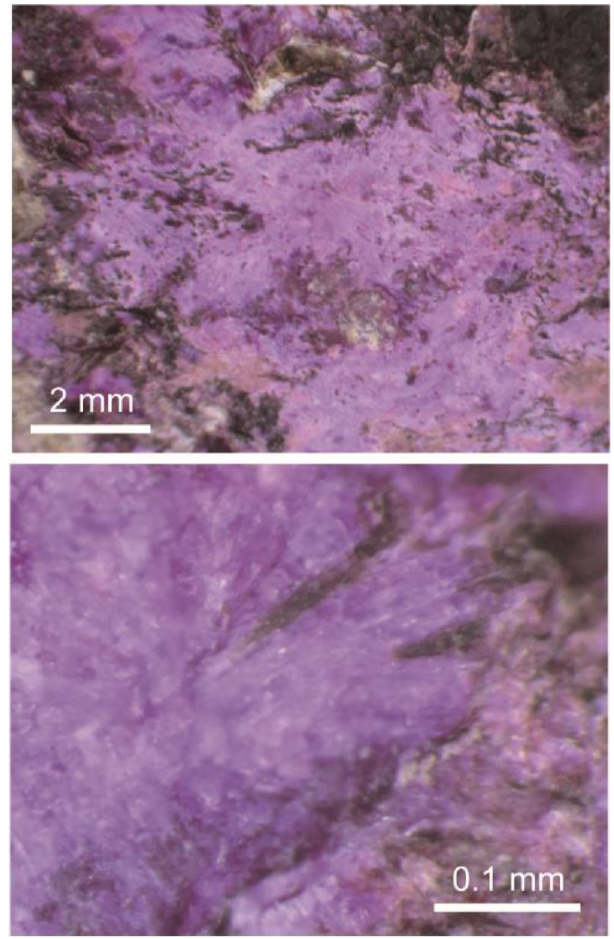
Figure 1. Microphotograph of